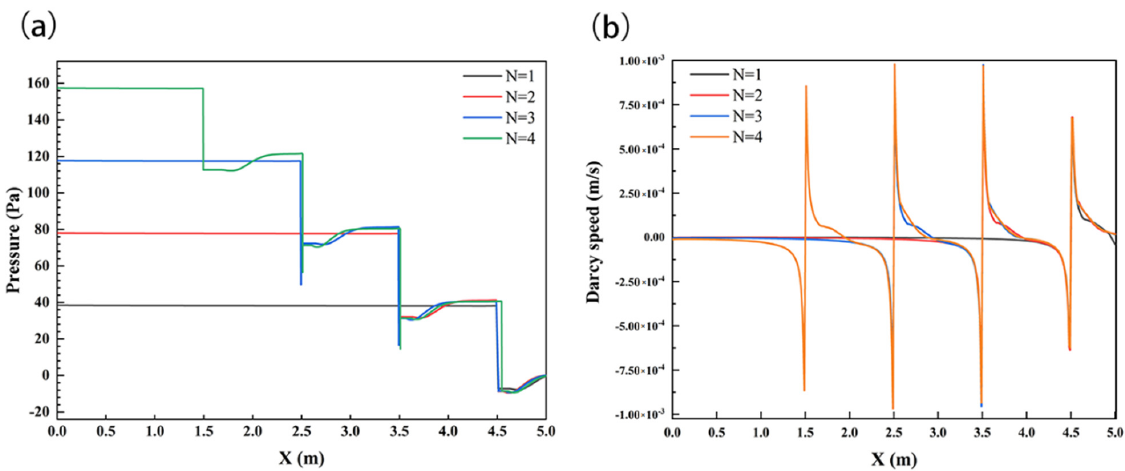
Figure 11. SWI pressure distribution ( a ) and velocity distribution ( b ) under the influence of different structure numbers N . Channel flow is left to right.